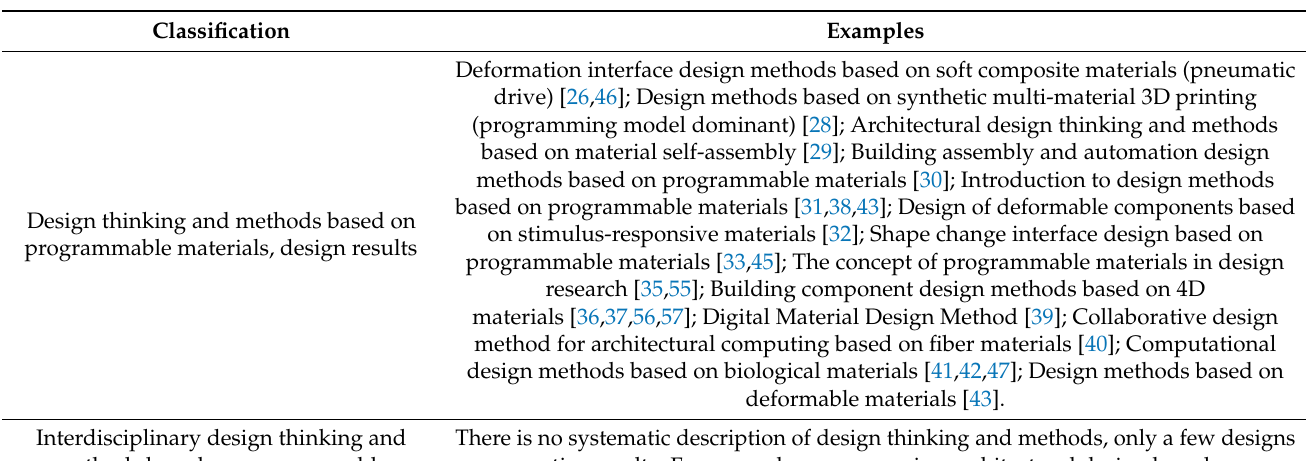
Table 3. Examples of current state of interdisciplinary research on design and programmable materials and programmable mechanical